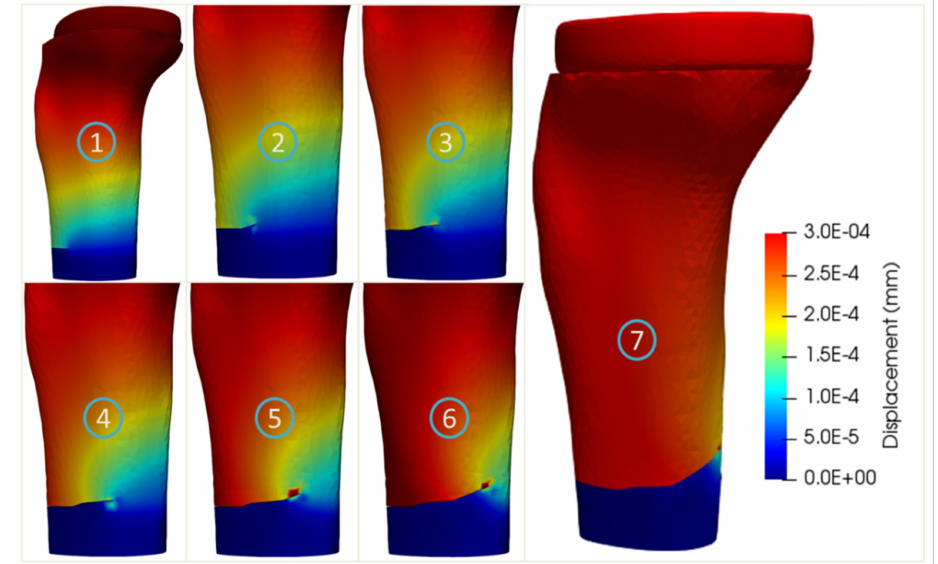
Figure 13. Crack propagation of the tibia bone model with implant of the 56-year-old